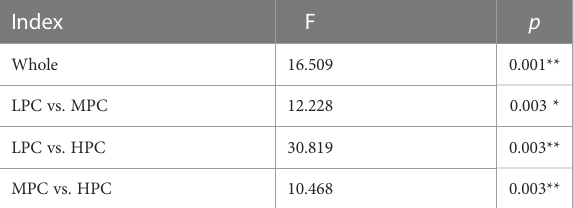
TABLE 1 Permutational multivariate analysis of variance ( PERMANOVA) and pairwise PERMANOVA of seawater bacterial community structure according to different phosphate groups.